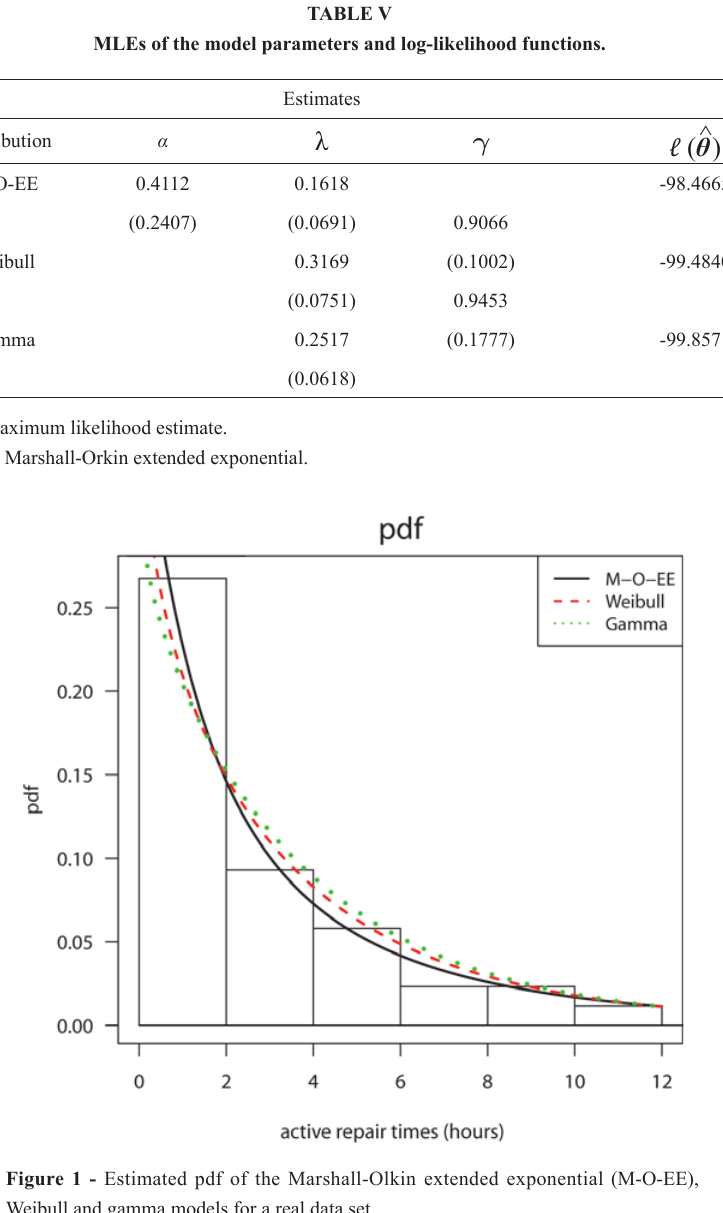
MLE: maximum likelihood estimate.